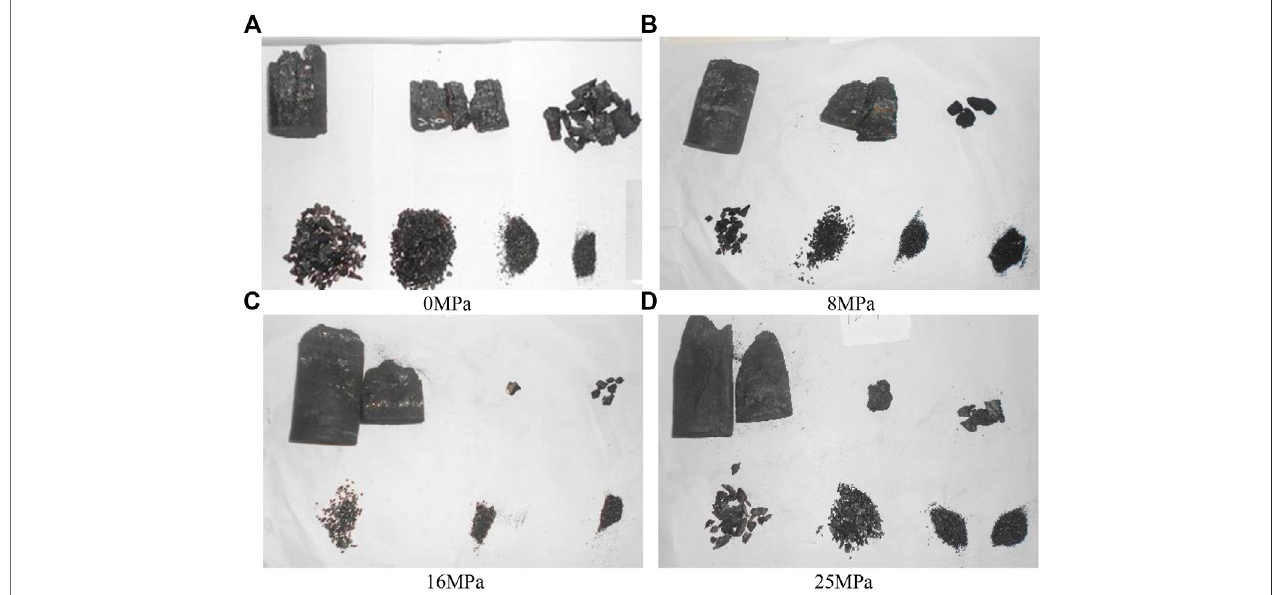
FIGURE 5 | Screen diagram of broken coal-rock block. (A) 0 MPa, (B) 8 MPa, (C) 16 MPa, (D) 25 MPa.